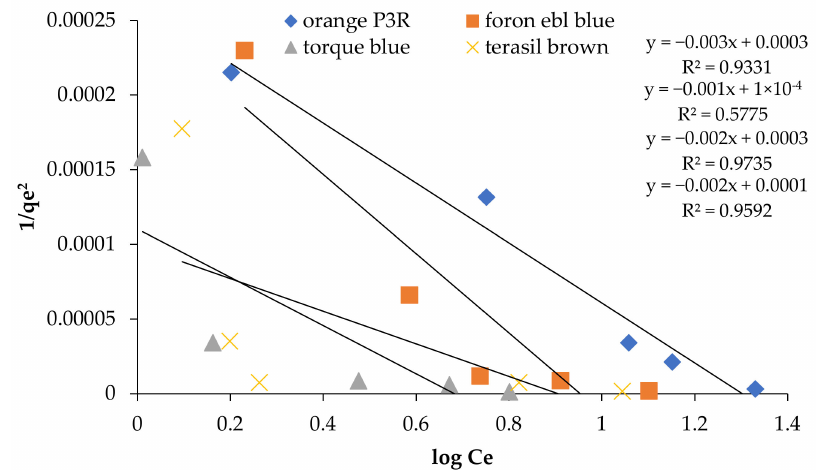
Figure 9. Harkin Jura Isotherm at 5 concentrations for non-calcinized composite.